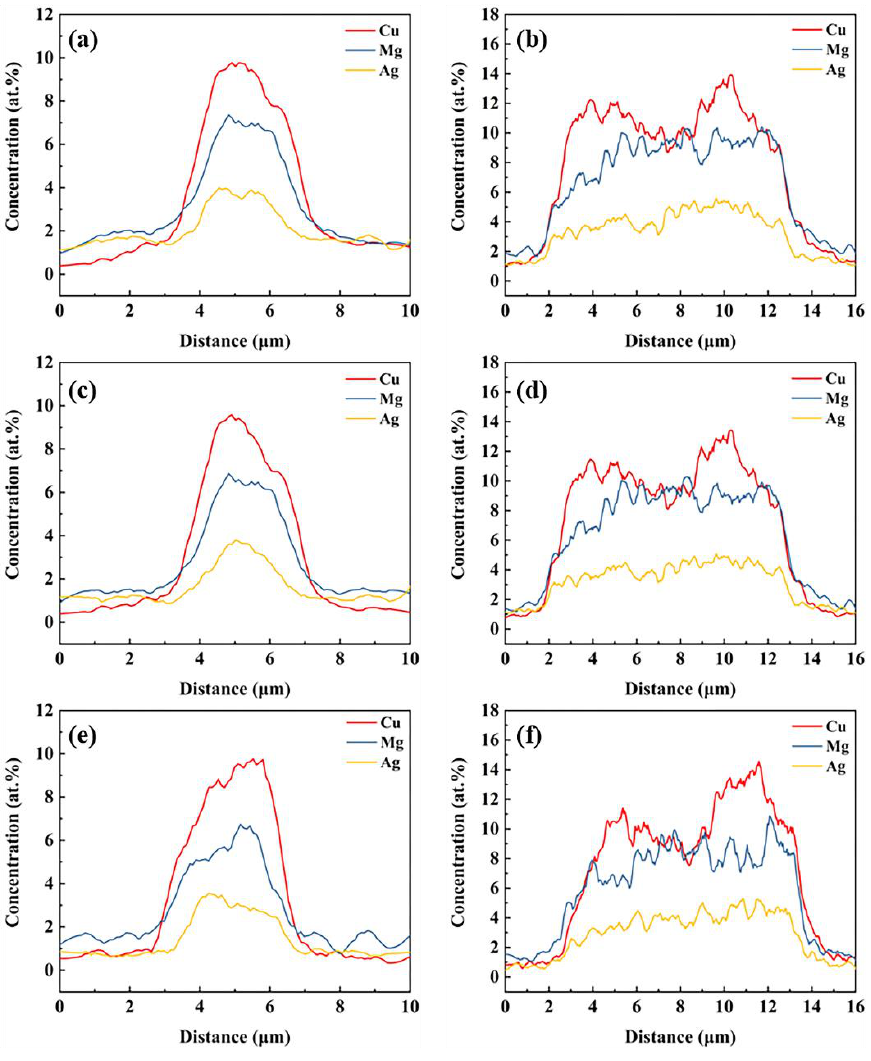
Figure 7. Elemental distribution along L1 ( a , c , e ) and L2 ( b , d , f ) at 100 °C ( a , b ), 200 °C ( c , d ) and 300 °C ( e , f ) of the sample.